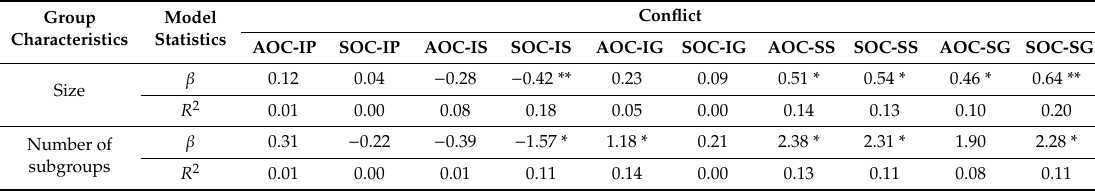
Table 1. Results of regression analysis of associations between the size and number of informal subgroups (independent variables) and conflict levels and types (dependent variables) in the group as a whole.